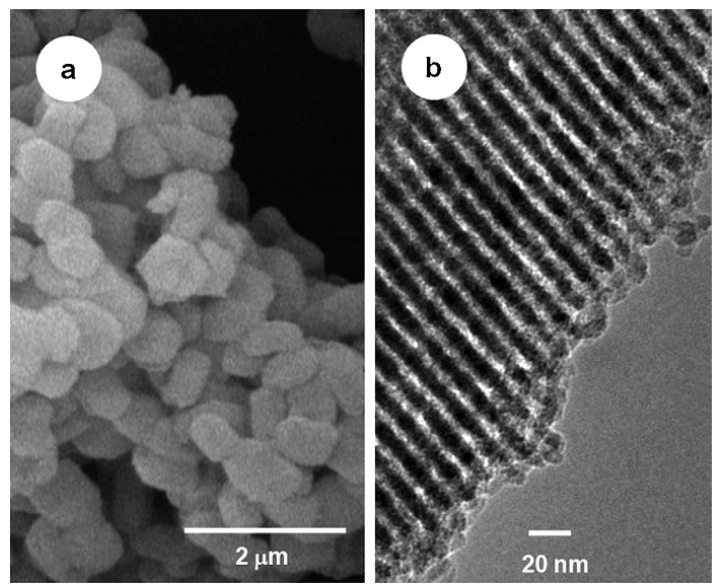
Fig. 3. SEM (a) and TEM (b) images of the SBA-SPS-Q compound [28].